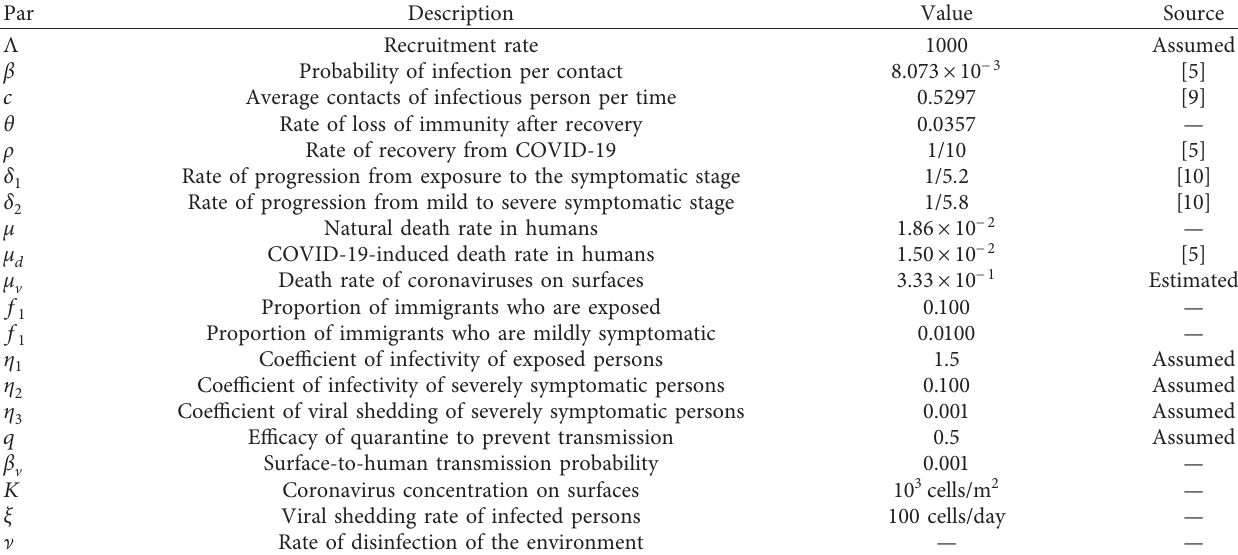
Table 1: Description of model parameters and baseline